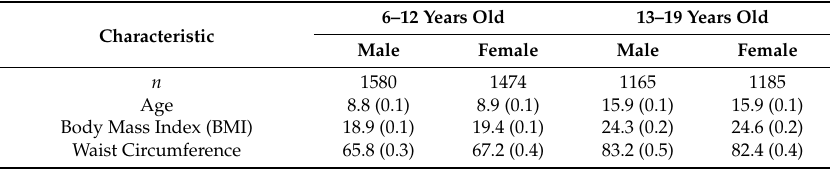
Table 1. Characteristics of children and adolescents by age and gender in National Health and Nutrition Examination Surveys (NHANES)